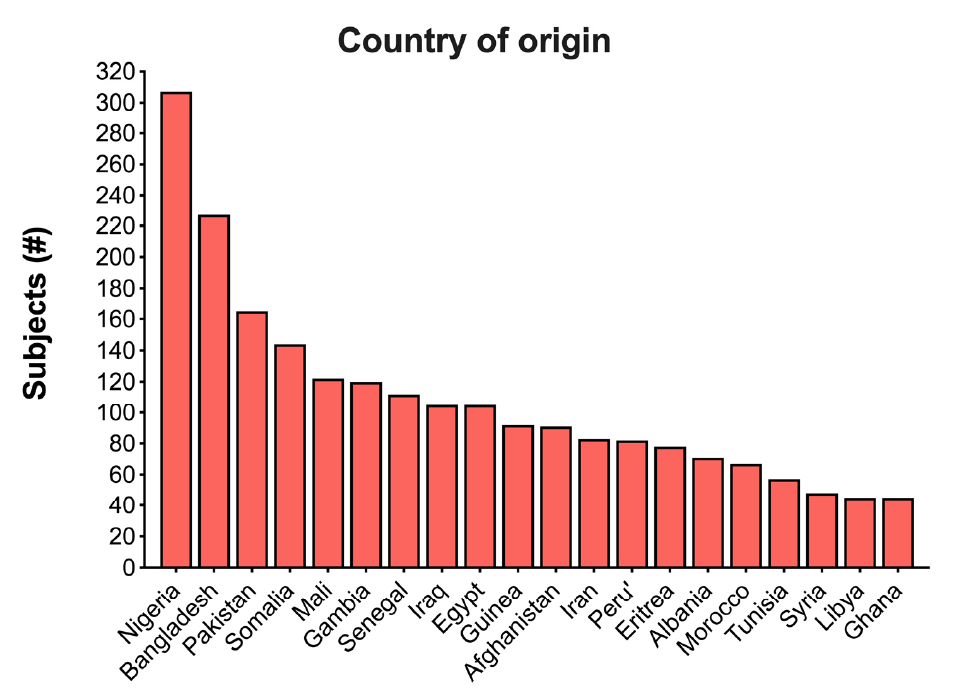
Figure 1. Distribution of the country of origin of the migrants screened in this project sorted by number of patients. Only the first 20 countries are shown.